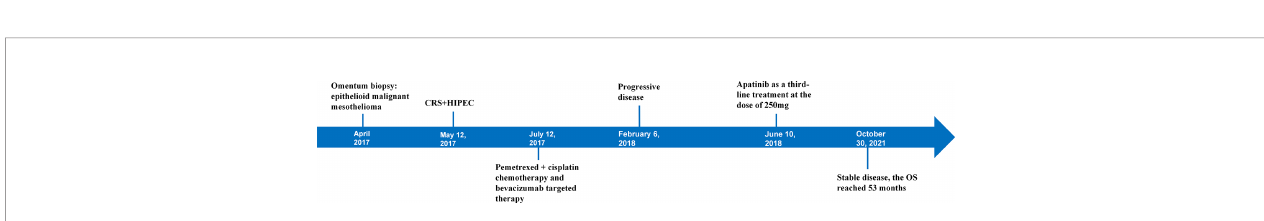
FIGURE 6 | Serum tumor makers during apatinib treatment. (A) The change curve of CA125, during apatinib treatment, the values were normal; (B) The change curve of CA199; (C) The change curve of CEA.